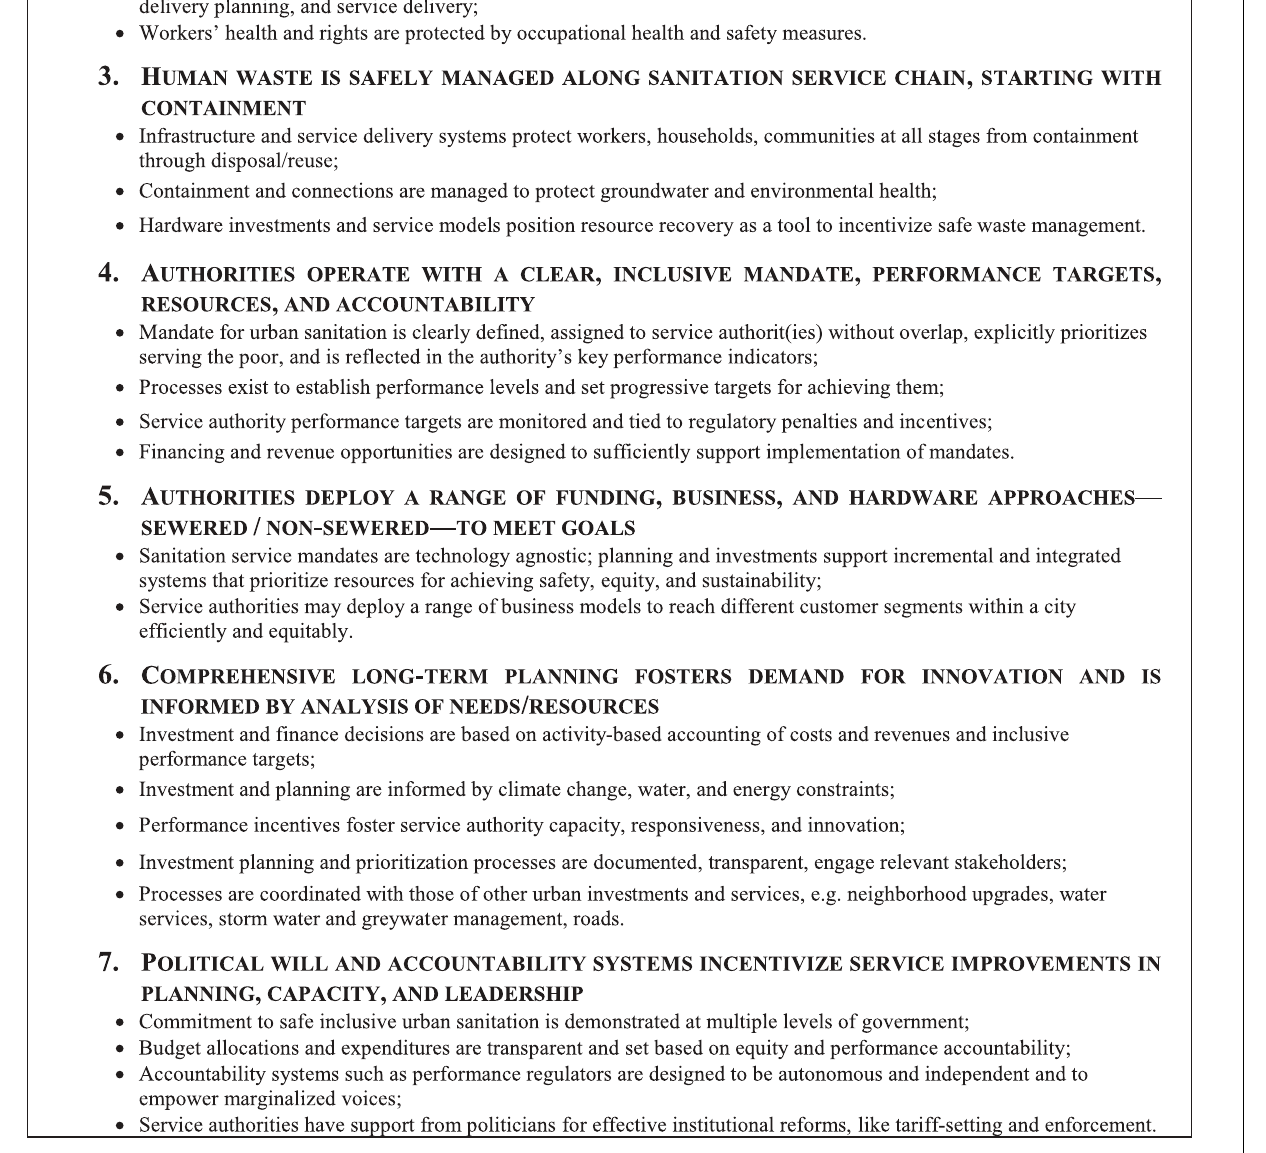
FIGURE 1 | Seven principles for citywide inclusive